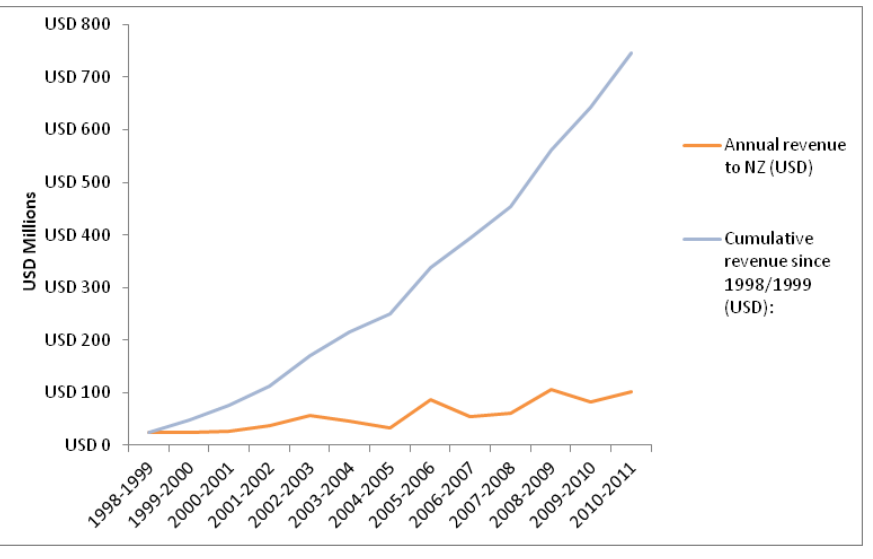
Figure 1. Annual and cumulative revenue from clinical